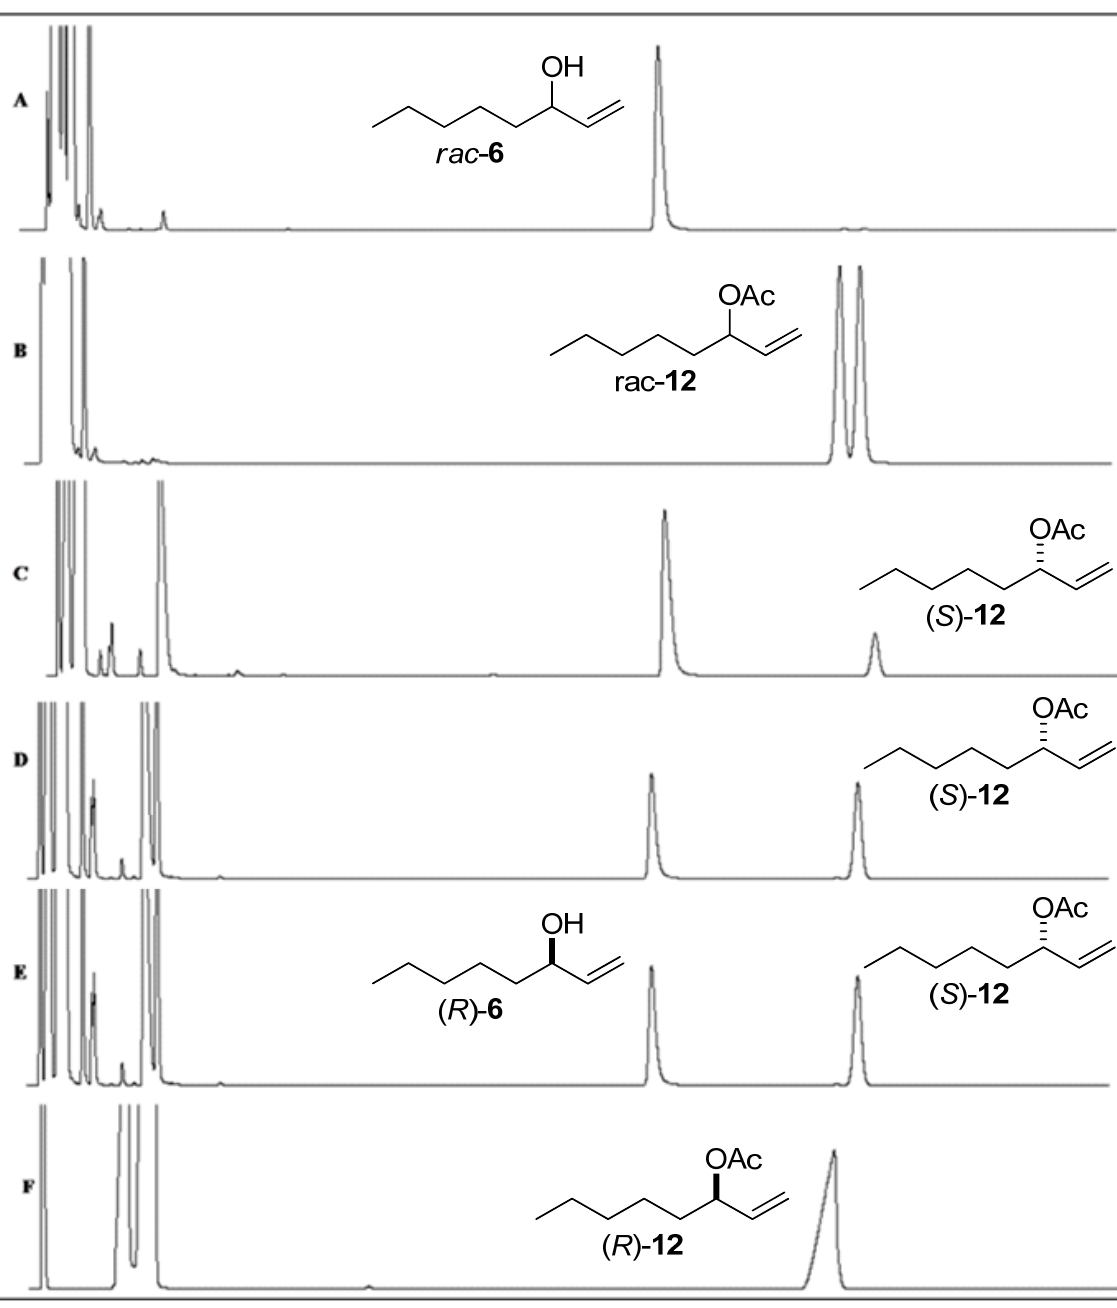
Figure 3. Chiral analyses obtained by GC-FID chromatograms. ( A ) Racemic alcohol (±)- 6 . ( B ) Racemic acetate (±)- 12 . ( C ) Chromatograms of the kinetic resolution of rac - 6 by lipase CALB (20 min). ( D ) Chromatograms of the kinetic resolution of rac - 6 by lipase CALB (40 min). ( E ) Chromatograms of the kinetic resolution of rac - 6 by lipase CALB (60 min). ( F ) Enantiopure acetate ( R )- 12 obtained after acetylating of alcohol ( R )- 6 by Ac